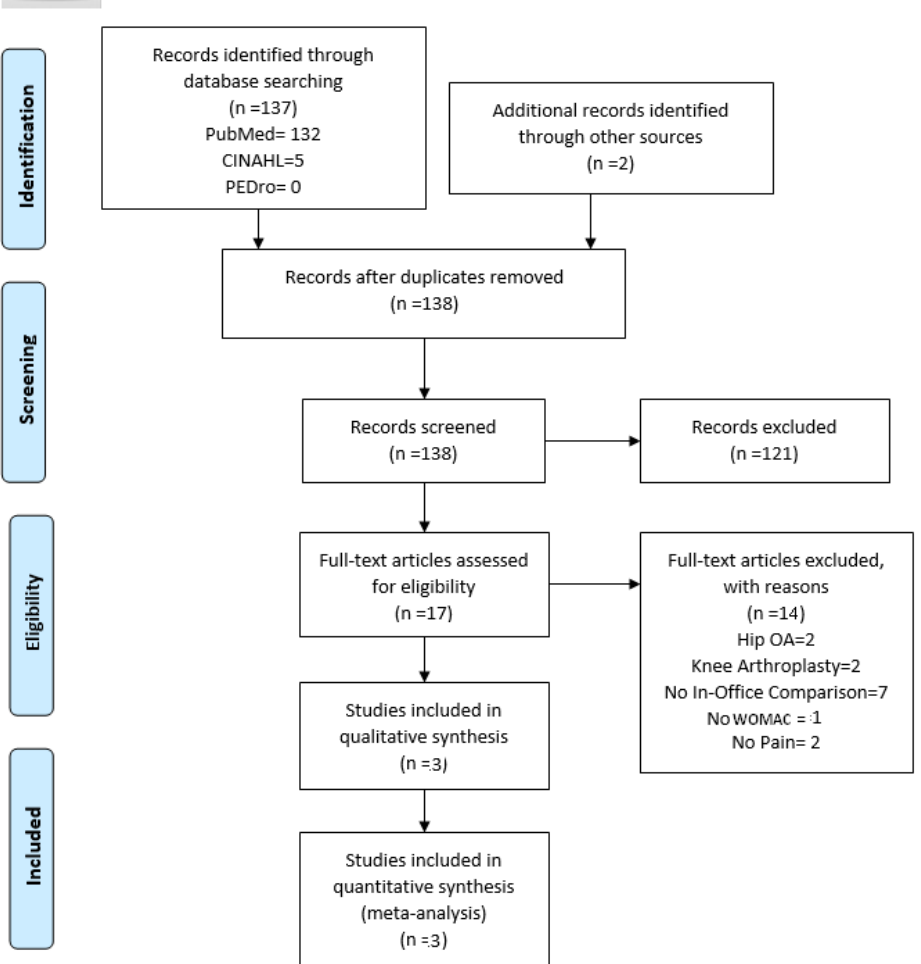
Figure 1. Graphical representation of our PRISMA flowchart. OA: osteoarthritis; WOMAC: Western Ontario and McMaster Universities Osteoarthritis Index. Table 3. Summary of the risk of bias within the three studies (screened for unbiased practices based on the 2005 Oxford standard [17].